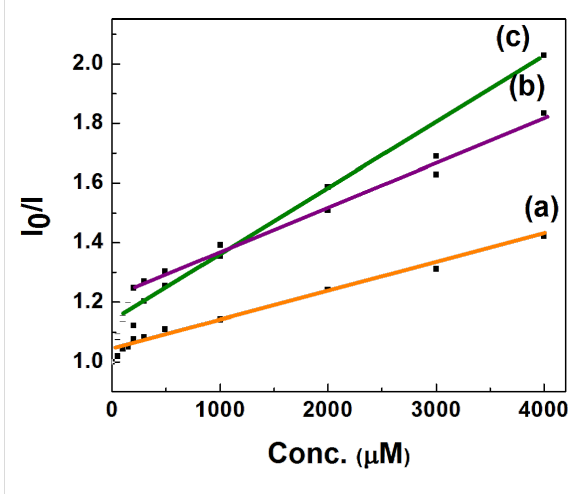
Figure 6: Emission intensity profile of polymer:chalcopyrite nanocom- posites as a function of the concentration of chalcopyrite nanocrystals ( λ max = 580 nm and concentration of chalcopyrites varying from 0–100 mM). (a) P3HT:CISe; (b) P3HT:CIGSe; and (c) P3HT:CZTSe.